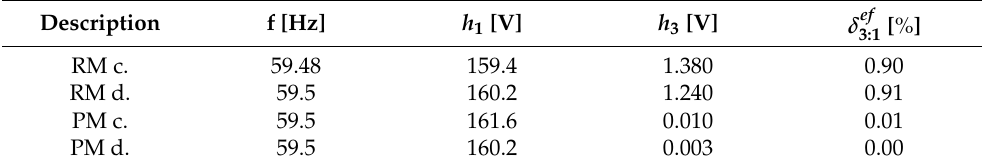
Table 6. Nominal RC load.